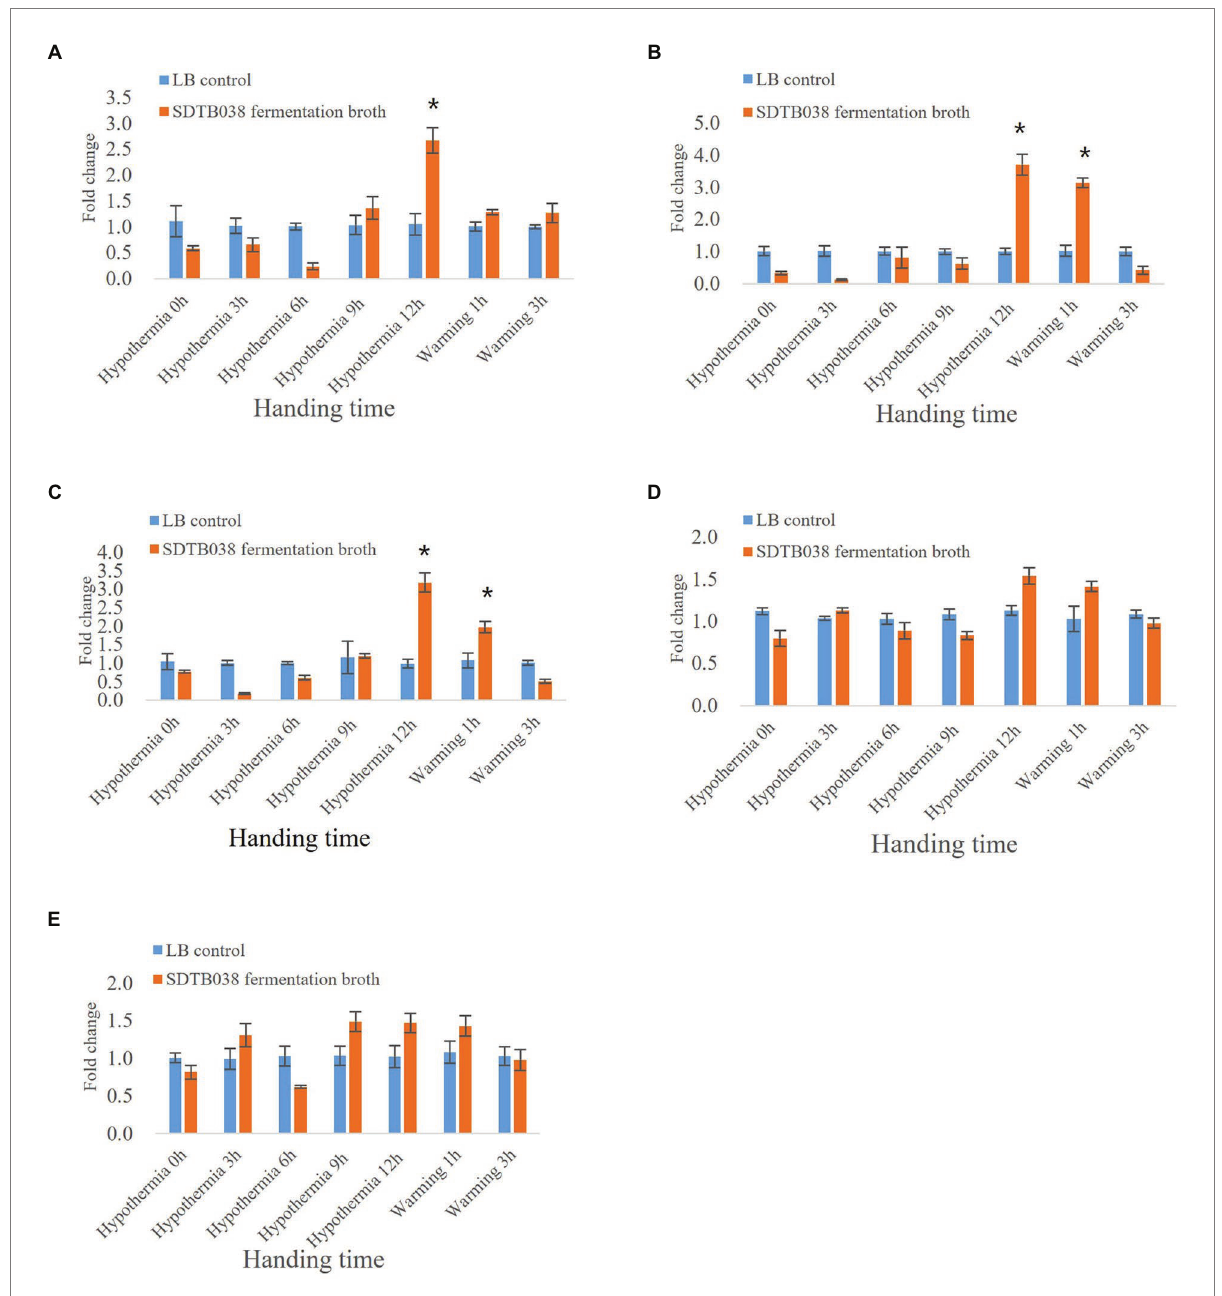
FIGURE 4 Expression of SDTB038 on antifreeze genes at low temperature. (A) SIMPK3 gene expression; (B) SIHSP17.7 gene expression; (C) SLMYB7 gene expression; (D) SICPK8 gene expression; (E) SIHY5 gene expression. Asterisks indicate significant differences between tomato plants inoculated with SDTB038 broth and those inoculated with liquid LB. The different lowercases represent significant level ( p = 0.05) according to the Duncan’s